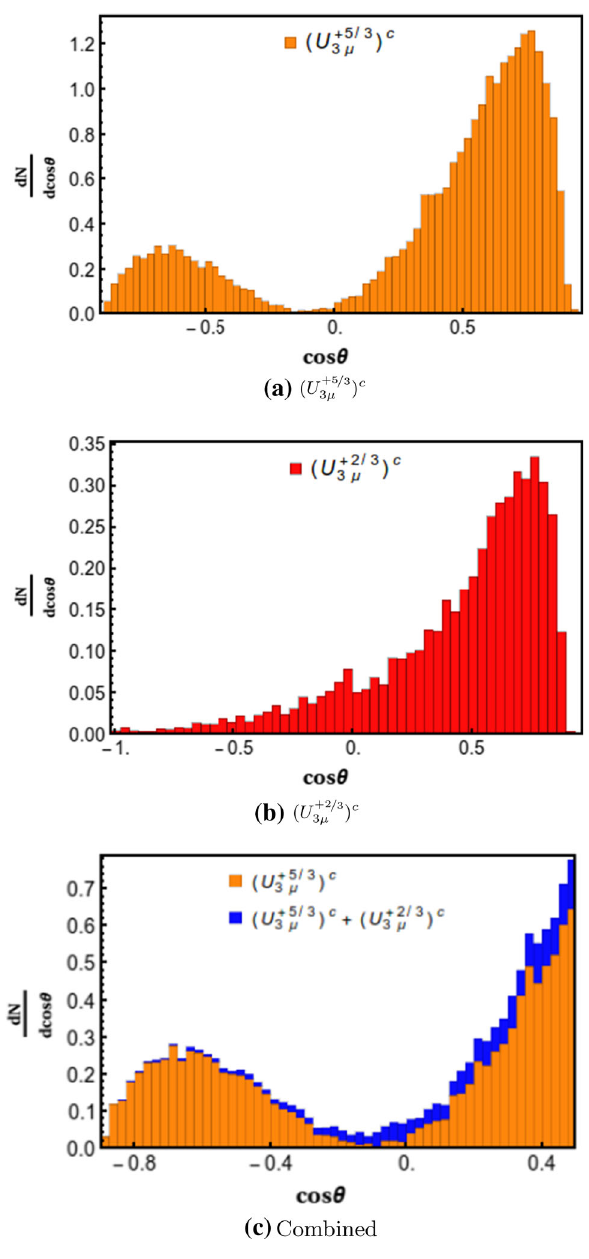
Fig. 14 Angular distribution of photon with respect to the electron √ s = 318 . 12 GeV and L int = 100 fb − 1 for the associated beam, at production of 70 GeV vector triplet leptoquark U c in CM frame. The 3 μ / 3 ) c , the second one first plot shows the angular distribution of ( U + 5 3 μ / 3 ) c , and the last one exhibits the angular distri- shows the same for ( U + 2 3 μ butionforsignalandbackgroundtogetherintherestframeofinteraction